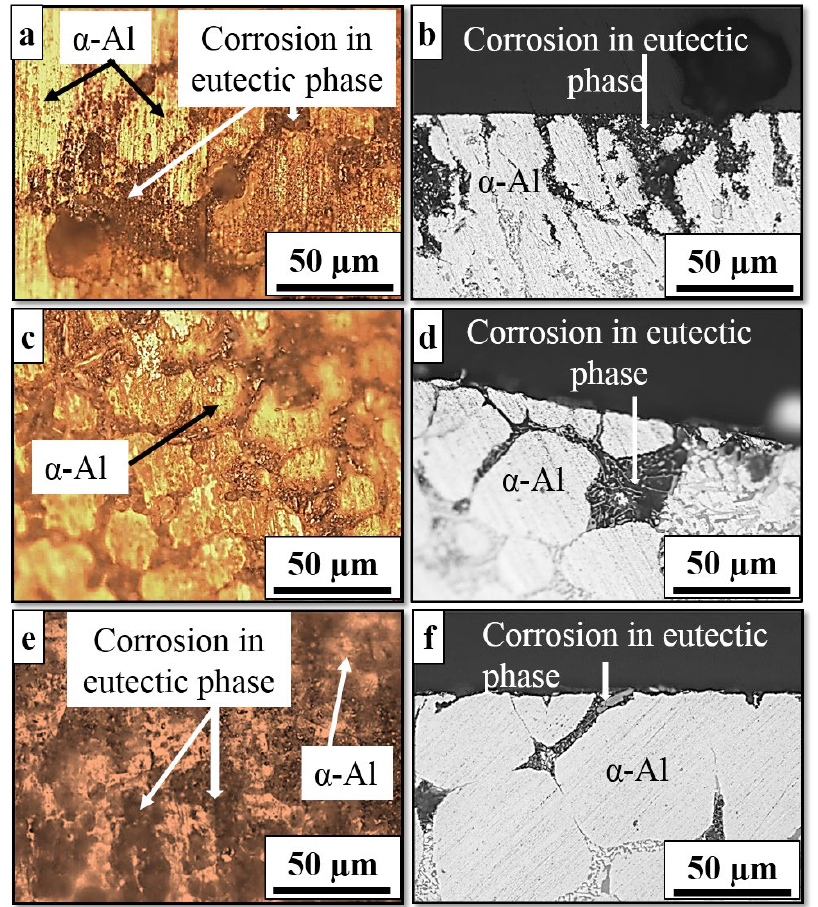
Figure 8. Optical micrographs of the surface morphology (top and side view) of ( a,b ) as-cast, ( c,d ) cooling slope and ( e,f ) thixoformed after 10 days of immersion in 3.5% NaCl